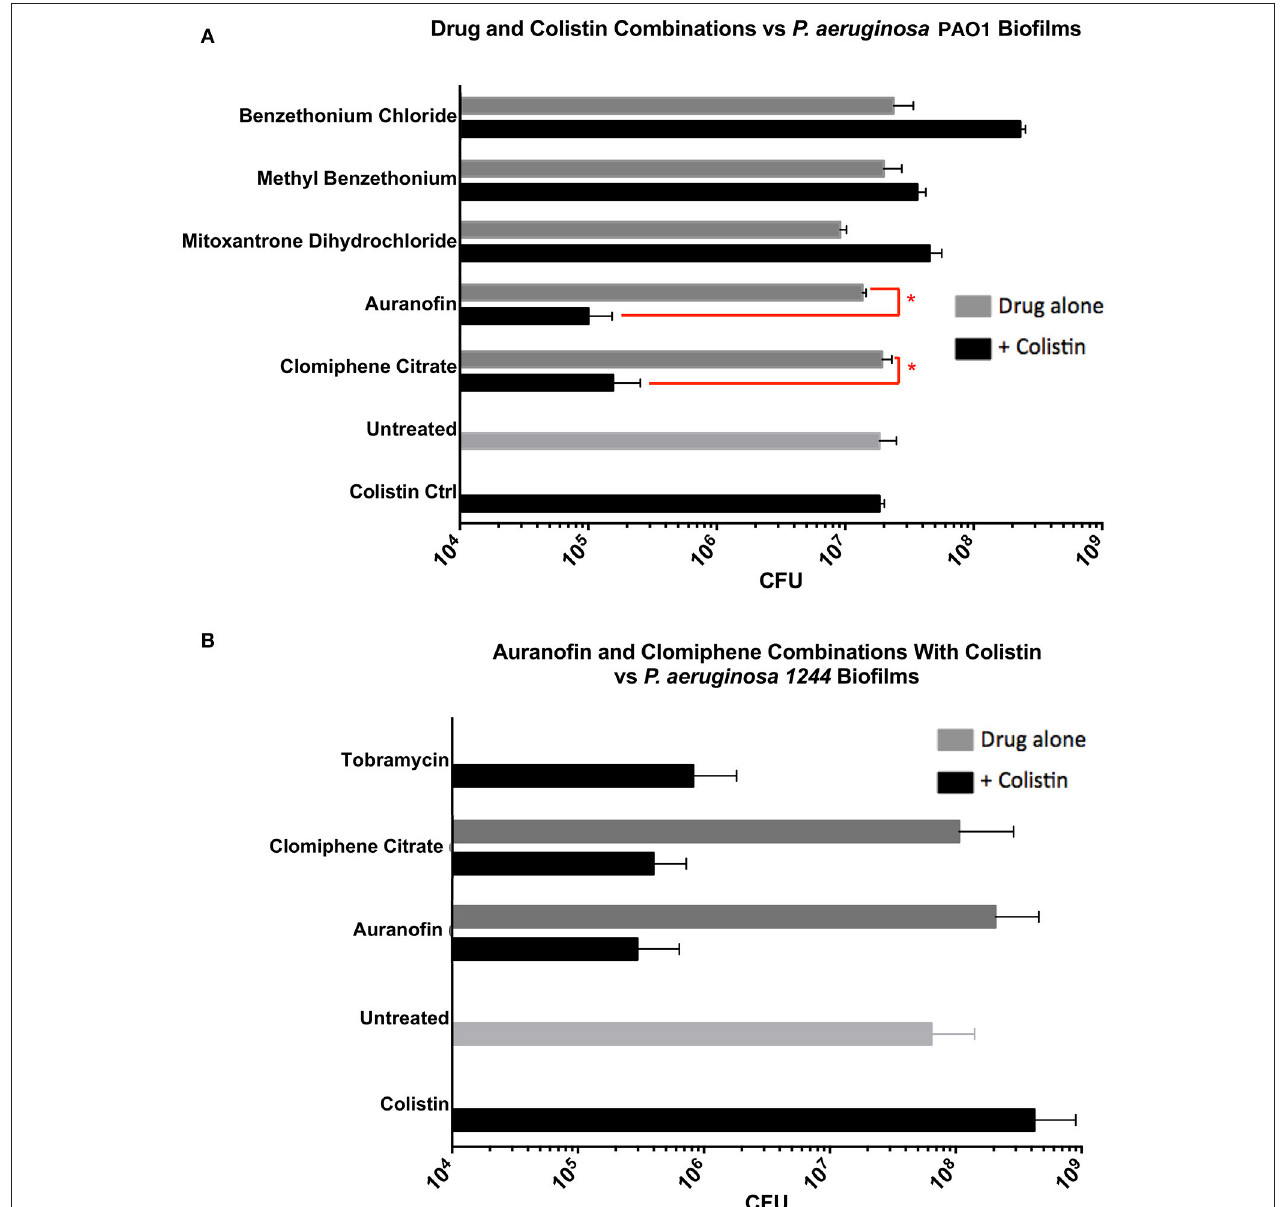
FIGURE 5 | (A) Pre-formed biofilms of P. aeruginosa (PA01) were treated with selected Colistin combinations. Only two combinations, Auranofin/Colistin (1.56 µ M/6.24 µ g/mL) and Clomiphene Citrate/Colistin (6.25 µ M/3.12 µ g/mL), showed activity against biofilms. (B) Pre-formed biofilms of P. aeruginosa 1244 were treated with Auranofin/Colistin (1.56 µ M/6.24 µ g/mL) and Clomiphene Citrate/Colistin (6.25 µ M/3.12 µ g/mL). As with PA01, there was a 2-log reduction in 1244 cell survival. * P < 0.05, n =